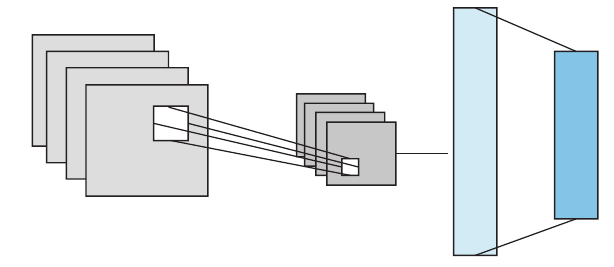
Figure 2: CNN feature extraction model.